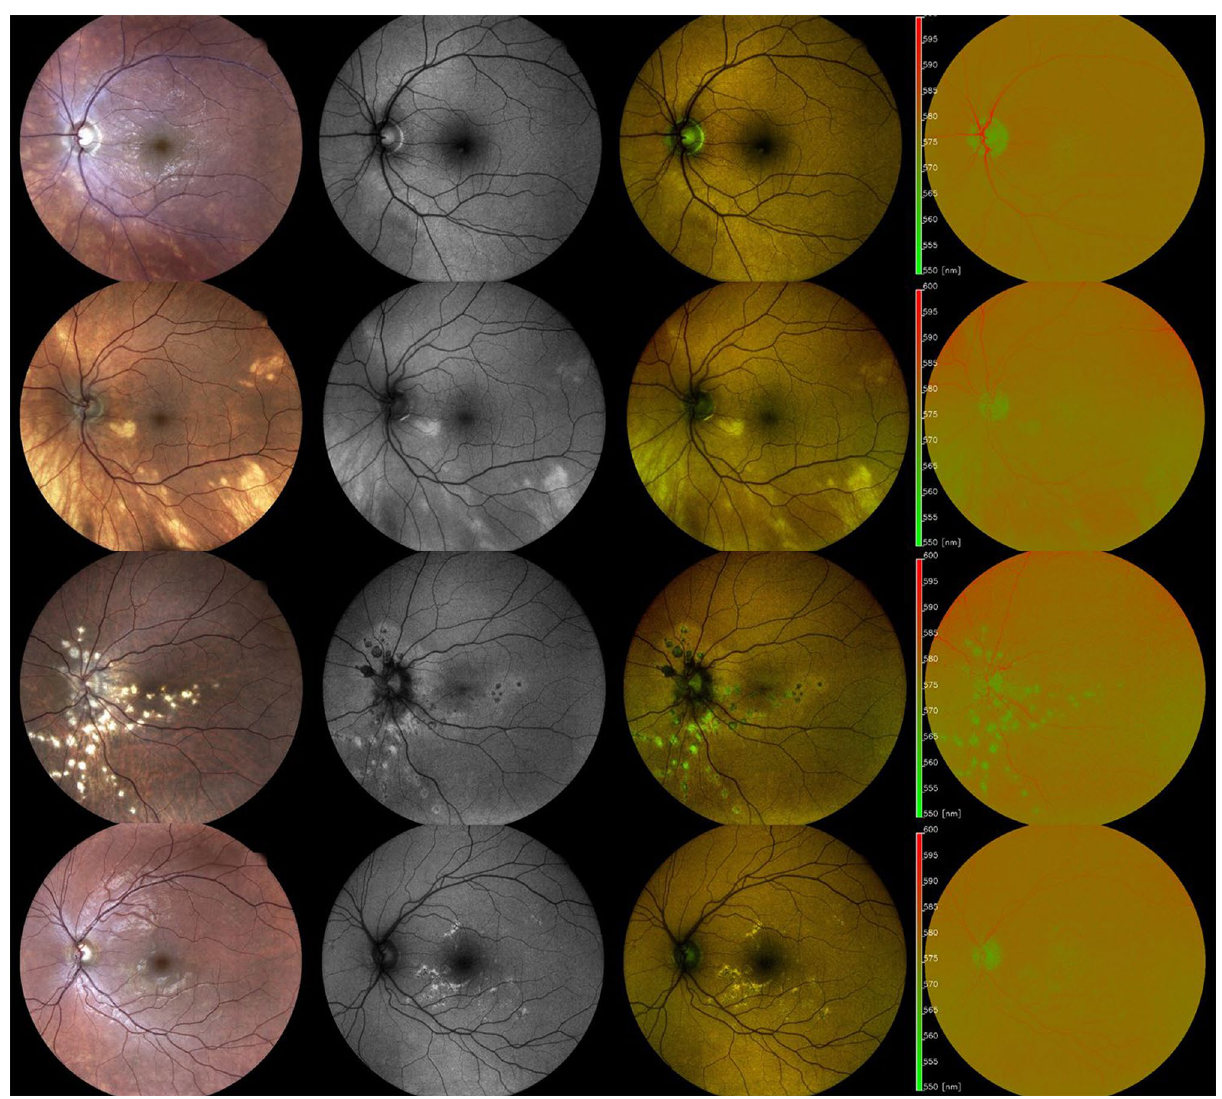
Figure 2. Comparison of birdshot chorioretinopathy, ocular sarcoidosis, punctate inner choroidopathy (PIC), and acute posterior multifocal placoid pigment epitheliopathy (APMPPE) on spectrally resolved autofluorescence (Color-FAF) imaging. An exemplary eye with birdshot chorioretinopathy (first row), ocular sarcoidosis (second row), PIC (third row), and APMPPE (fourth row) are illustrated. From left to right: color fundus photography (CFP), grayscale fundus autofluorescence image (grayscale FAF), spectrally resolved fundus autofluorescence (Color-FAF) image, intensity-normalized Color-FAF. Lesions of eyes affected by ocular sarcoidosis were more apparent than in eyes with birdshot chorioretinopathy on grayscale FAF, Color-FAF, and intensity-normalized Color-FAF. Lesions of eyes with PIC were clearly apparent in all four modalities. Lesions of eyes affected by APMPPE were hardly visible on CFP and on intensity-normalized Color-FAF, whereas they were easily definable on Color-FAF and grayscale